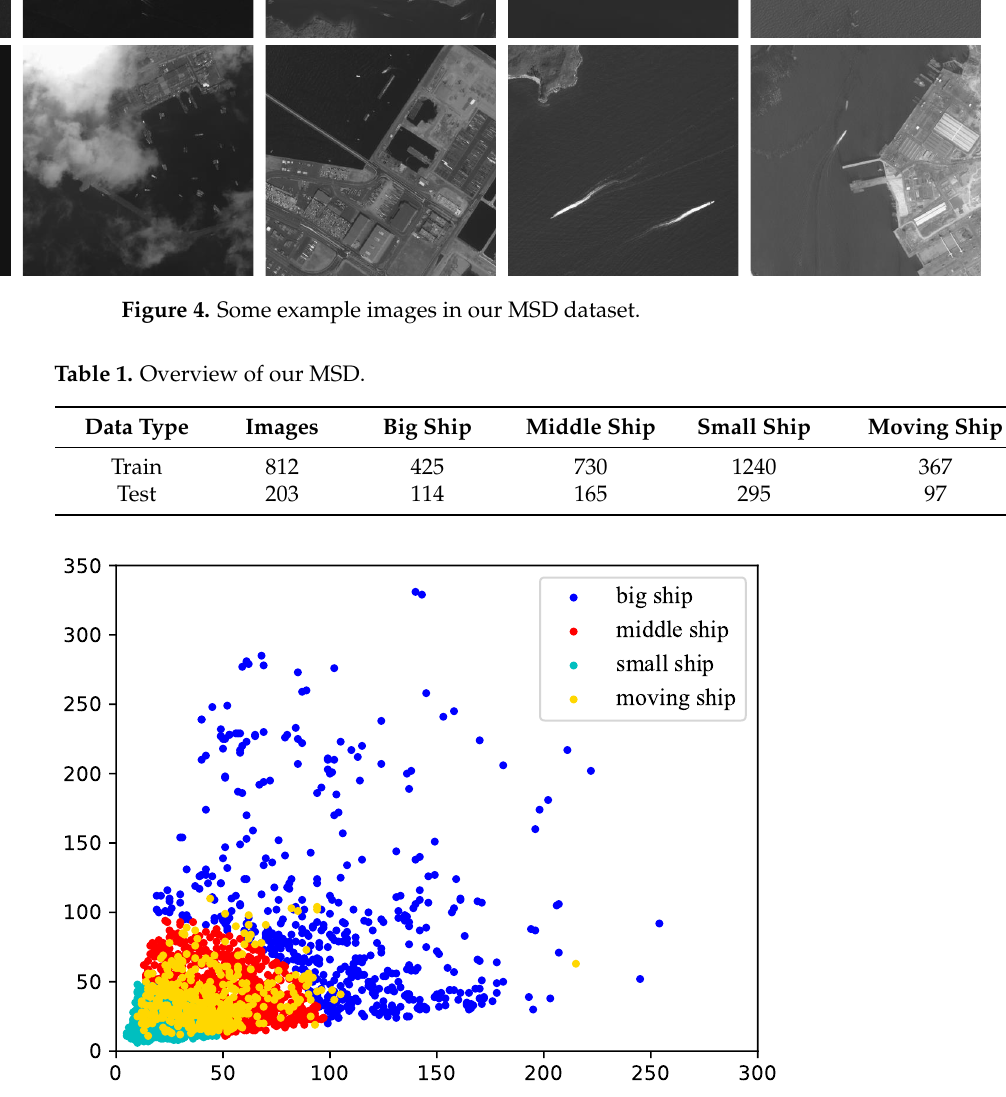
Figure 5. The sizes of ship targets in our dataset. As illustrated, ships have different scales and there exists large scale variations in